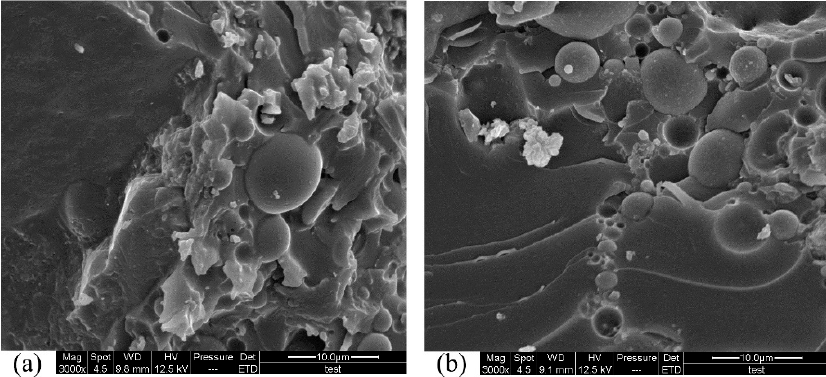
Figure 12. Interiors of NPG, ( a ) and ( c ), and LPG, ( b ) and ( d ), that were immersed in pH 0.5 acid solution.